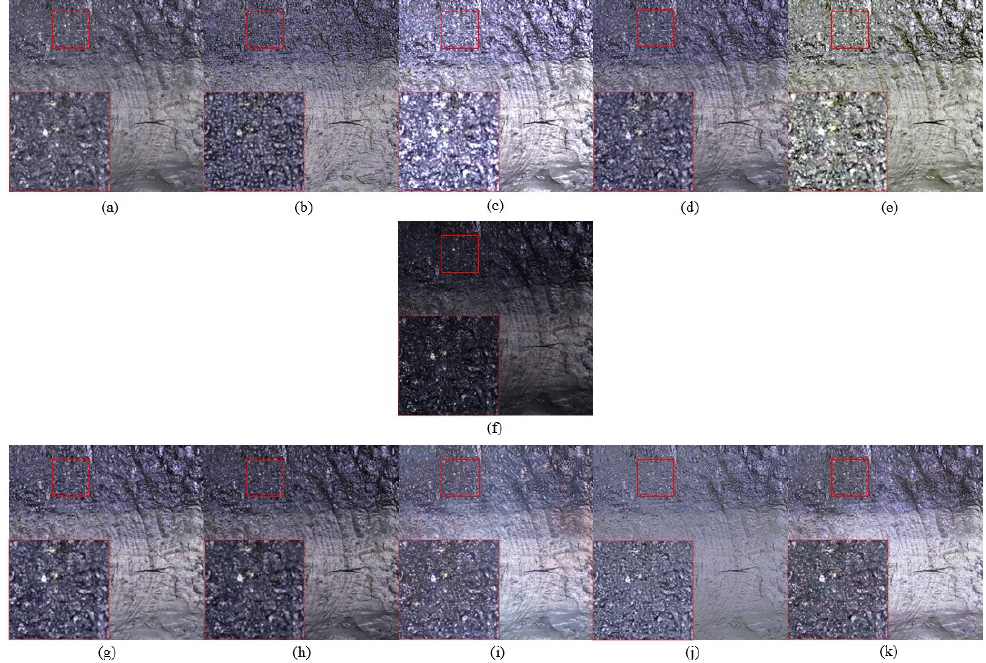
Figure 5. RCL dataset visual comparisons result on different methods. ( a ) BIMEF. ( b ) Dong. ( c ) LIME. ( d ) MF. ( e ) MultiscaleRetinex. ( f ) Input. ( g ) NPE. ( h ) SRIE. ( i ) EnlightGAN. ( j ) Zero-DCE. ( k ) Ours.